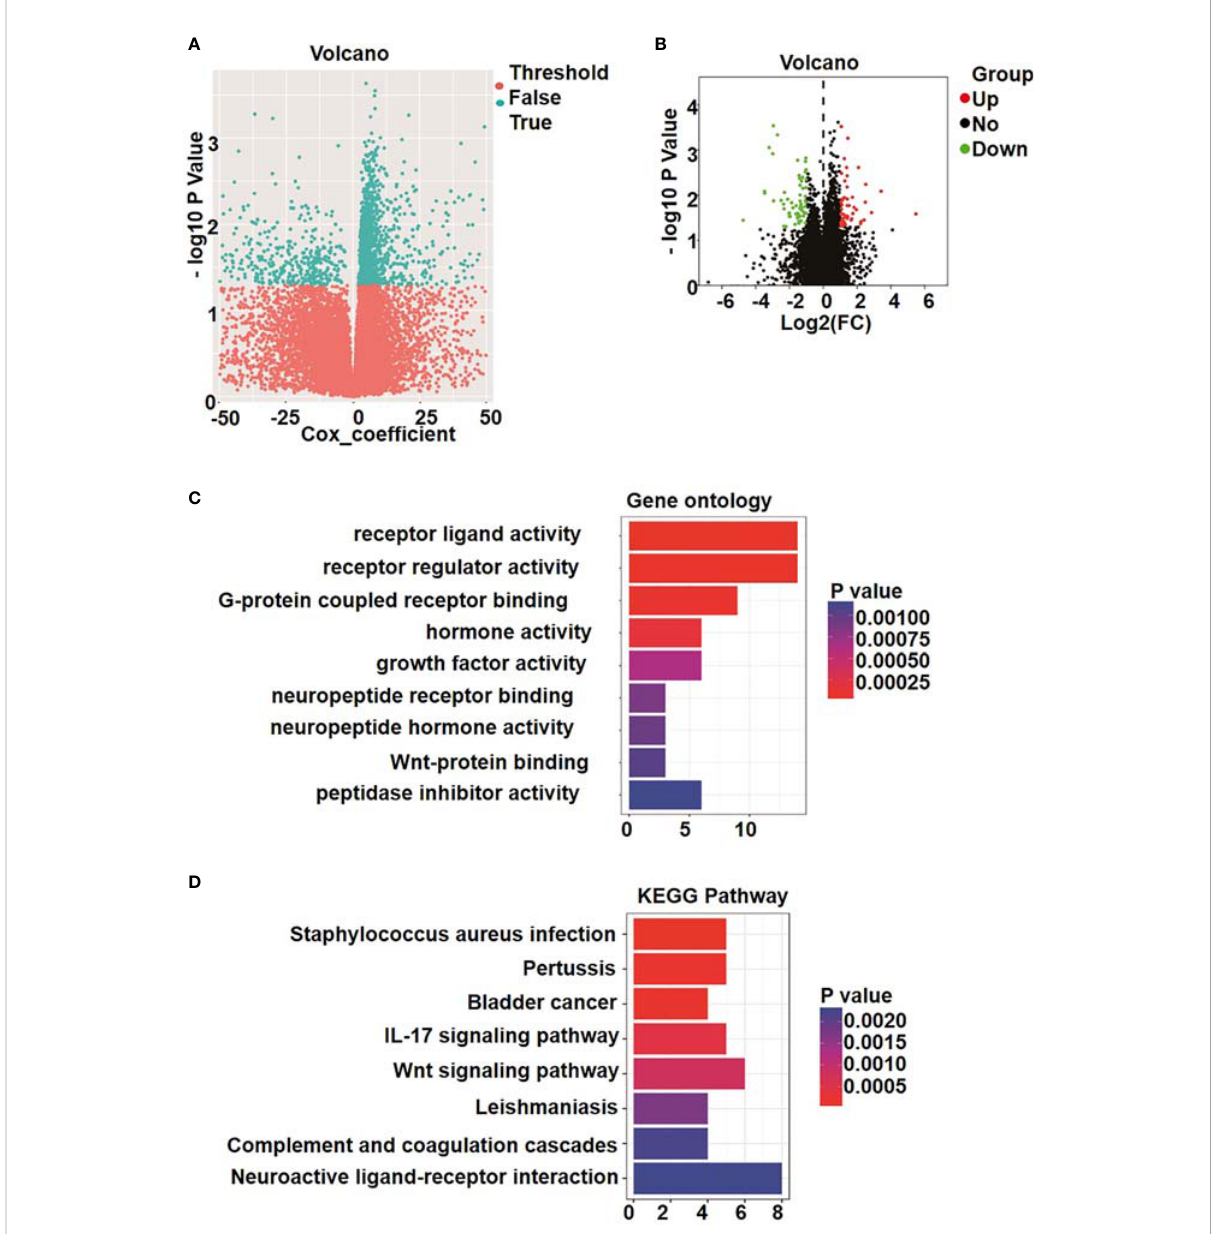
FIGURE 1 Identi fi cation of differently methylated and expressed genes. (A) Volcano plot shows the methylation data of 22 metastatic osteosarcoma and 64 non-metastatic osteosarcoma samples. A total of 1741 genes was considered to be signi fi cantly differently methylated, exhibiting in cyan dots. (B) Volcano plot of 147 genes in osteosarcoma patients. Blue color indicates up-regulated expression, and red color represents down- regulated genes. (C) Gene ontology (GO) enrichment analysis. (D) Kyoto Encyclopedia of Genes and Genomes analyses (KEGG) enrichment